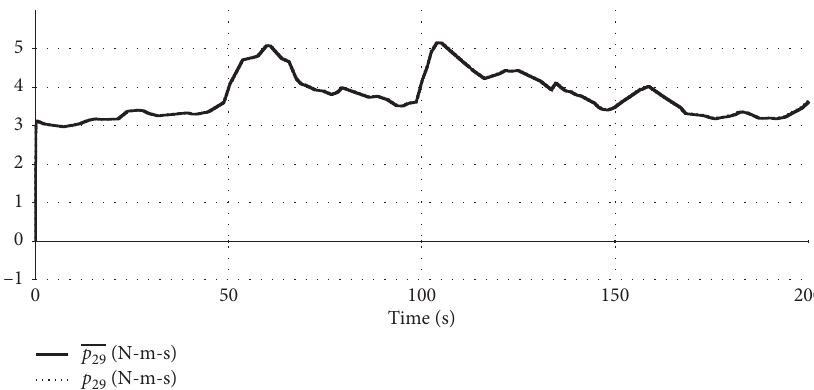
Figure 18: Full-time simulation of the slow variable p